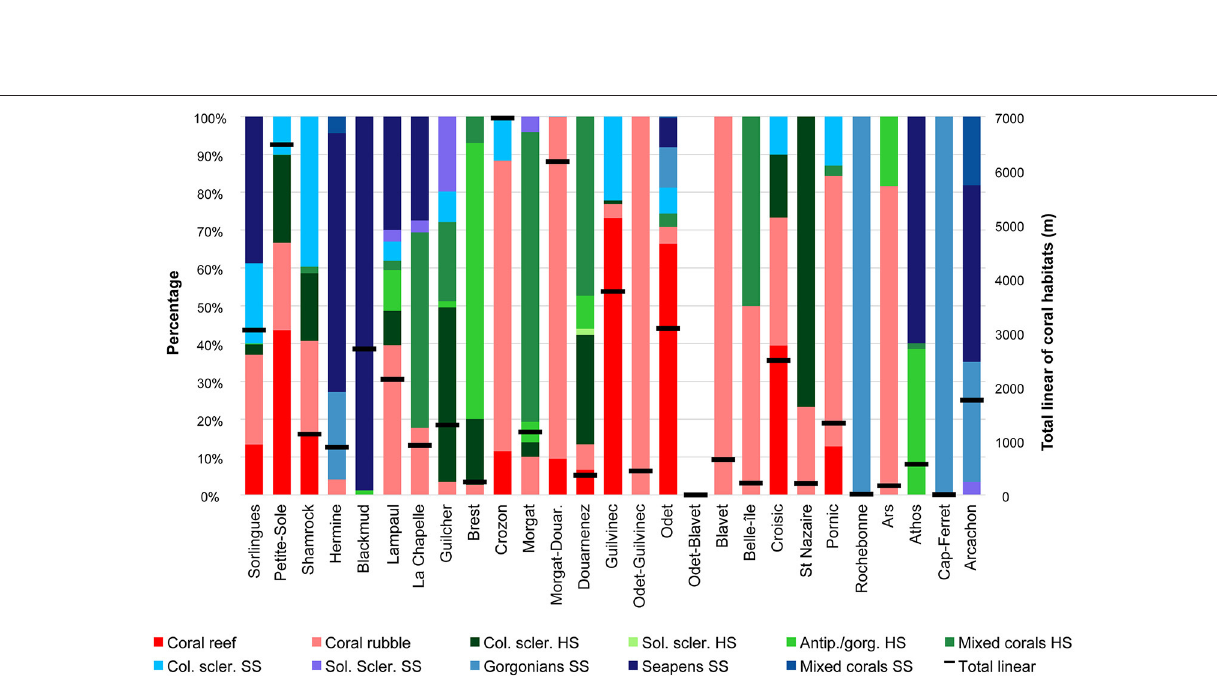
Frontiers in Marine Science |